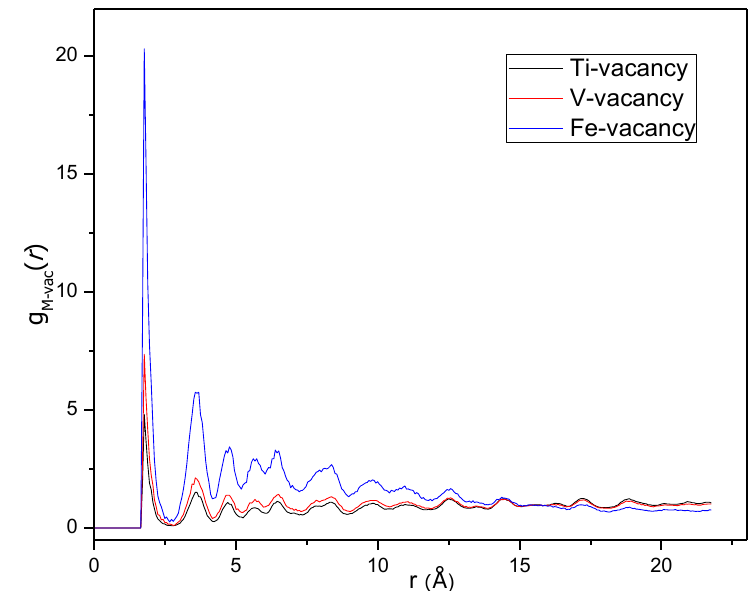
Figure 9. Vacancy-metal partial pair distribution functions g Ti-vac ( r ), g V-vac ( r ) and g Fe-vac ( r ) from an RMC model of Ti 0.63 V 0.27 Fe 0.10 D 1.73 .